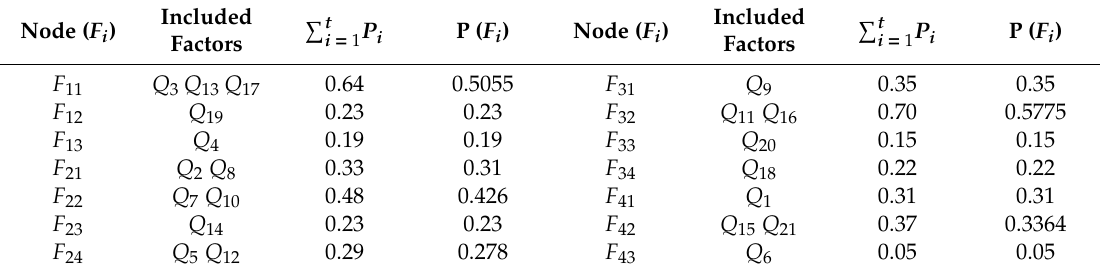
Table 6. The results of the prior probability.